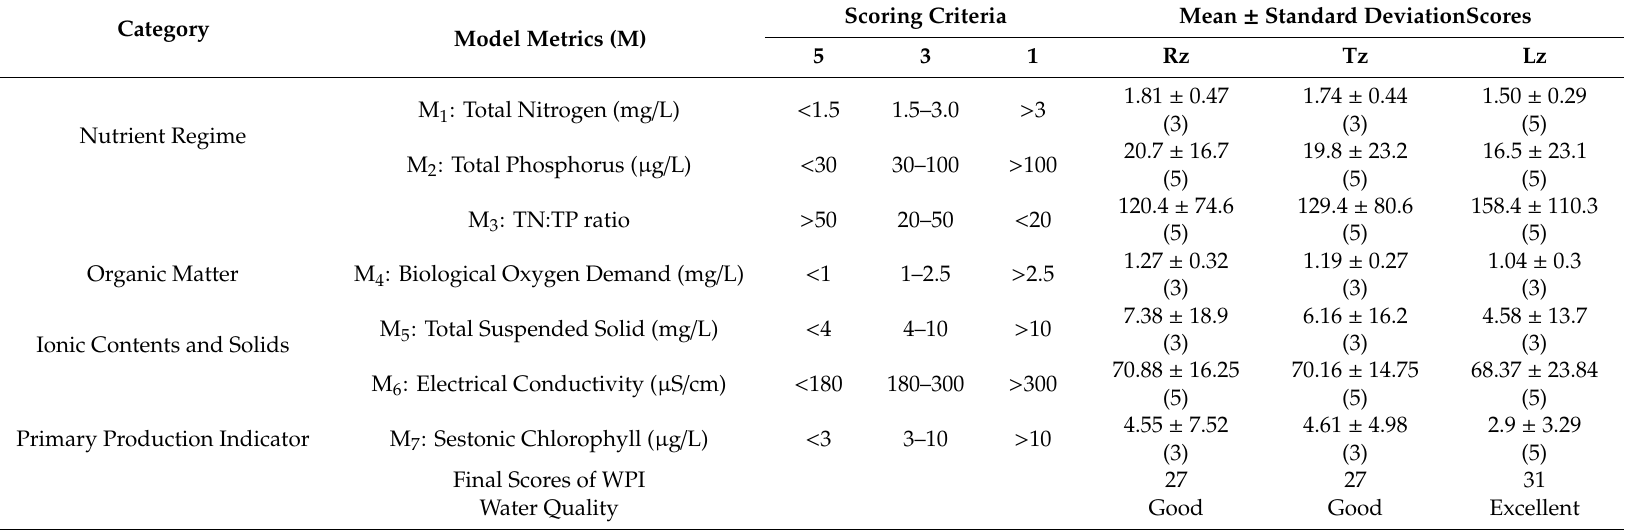
Table 4. Chemical health status of three zones of Lake Soyang based on modified water pollution index (WPI) during